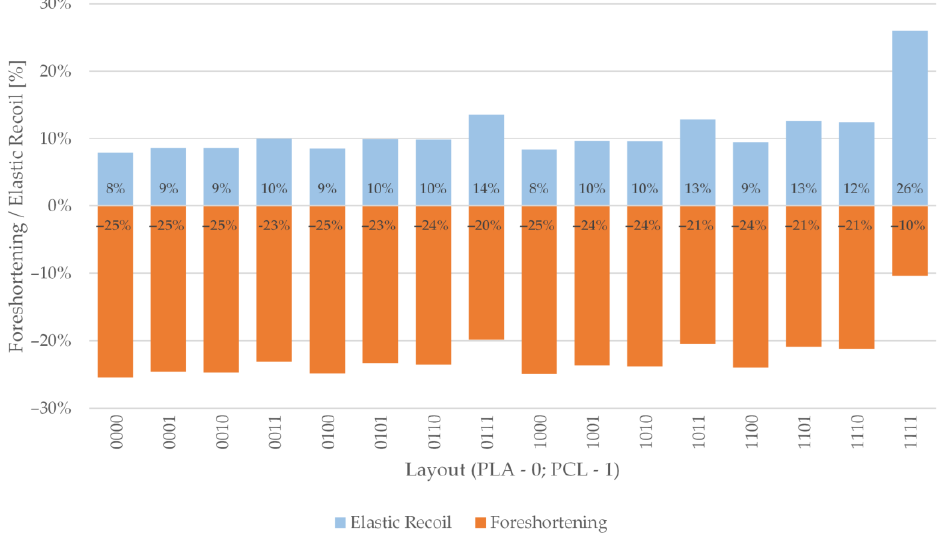
Figure 10. Radial elastic recoil and foreshortening results.